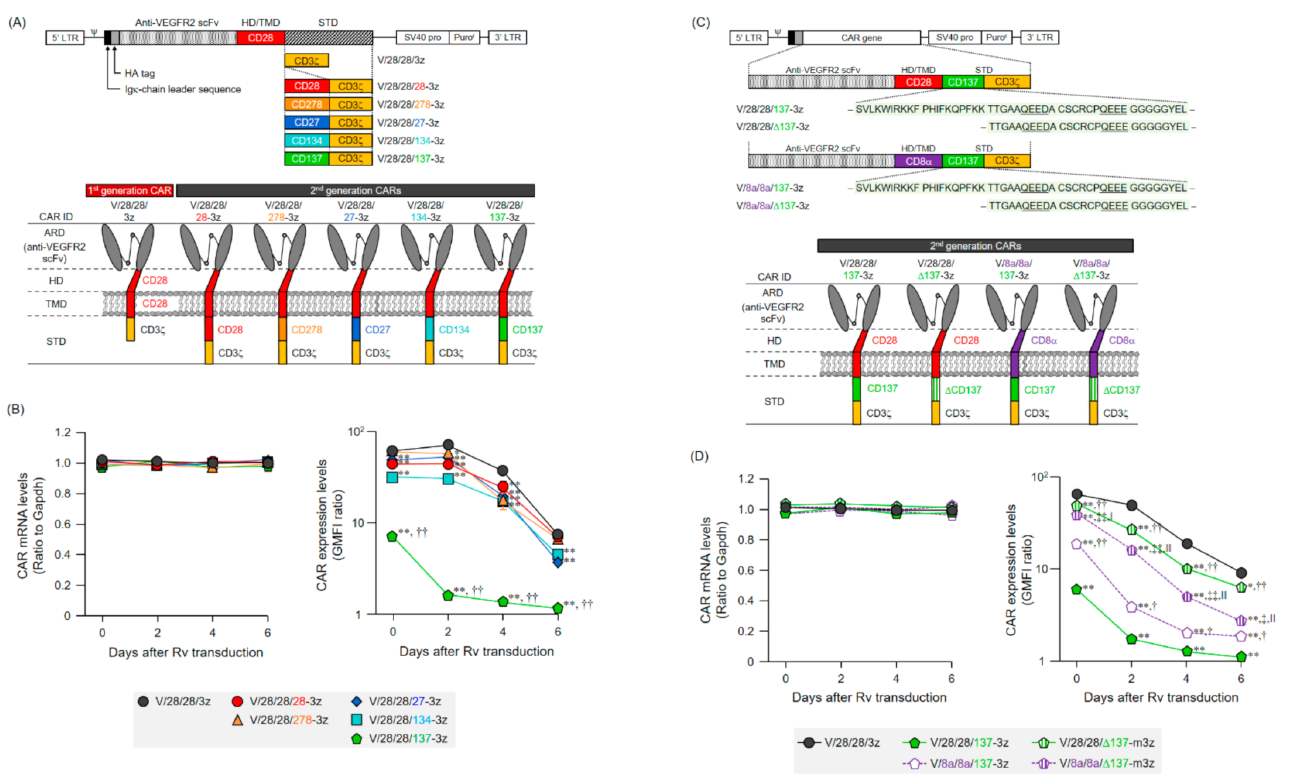
Figure 1. Expression of anti-mouse VEGFR2 second-generation CARs with different STDs. ( A ) Upper panel illustrates the Rv constructs containing the anti-mouse VEGFR2 first-generation CAR gene and second-generation CAR genes with a CD3 ζ -STD (1st STD) and 2nd STD derived from different co-stimulatory molecules for mouse T cells. Lower panel represents STD-modified CAR proteins. ( B ) The left panel shows the results of reverse transcription and quantitative PCR (RT-qPCR) analysis of CAR mRNA. CAR mRNA expression level is represented relative to that of Gapdh mRNA. The data are shown as the mean ± SD of triplicates, and are representative of two independent experiments. Statistical analysis was performed using the Dunnett’s test for multiple comparisons with V/28/28/3z and showed no significant differences. The right panel shows the results of flow cytometric analysis of CAR expression on CD8 + T cells using anti-HA-tag mAb or isotype control antibodies. Expression level of each CAR was calculated from the ratio of GMFI when stained with the anti-HA-tag mAb to GMFI when stained with the isotype control antibody. The data shows the mean ± SD of three individual experiments. Statistical analysis was performed using the Dunnett’s test for multiple comparisons with V/28/28/3z: ** p < 0.01; and using the Tukey’s test with V/28/28/137-3z versus V/28/28/28-3z, V/28/28/278-3z, V/28/28/27-3z, and V/28/28/134-3z: †† p < 0.01. ( C ) Upper panel illustrates the Rv constructs containing the anti-mouse VEGFR2 second-generation CAR genes with CD28- or CD8 α -derived HD/TMD and CD137-derived STD or truncated CD137 ( ∆ CD137)-derived STD for mouse T cells. Lower panel shows representation of the corresponding CAR proteins. ( D ) The left panel shows the results of RT-qPCR analysis of CAR mRNA. CAR mRNA expression level is represented relative to that of Gapdh mRNA. The data are shown as the mean ± SD of triplicates, and are representative of two independent experiments. Statistical analysis was performed using the Tukey’s test for multiple comparisons and showed no significant differences. Right panel, CAR expression on T cells was analyzed by flow cytometry. The expression level of each CAR was calculated from the ratio of GMFI when stained with the anti-HA-tag mAb to GMFI when stained with the isotype control antibody. The data shows the mean ± SD from three individual experiments. Statistical analysis was performed using the Dunnett’s test for multiple comparisons with V/28/28/3z: * p < 0.05 and ** p < 0.01; and using the Tukey’s test with V/8a/8a/137-3z and V/28/28/ ∆ 137-3z versus V/28/28/137-3z: † p < 0.05 and †† p < 0.01; V/8a/8a/ ∆ 137-3z versus V/28/28/ ∆ 137-3z: ‡ p < 0.05 and ‡‡ p < 0.01; V/8a/8a/ ∆ 137-3z versus V/8a/8a/137-3z: | p < 0.05 and (cid:107) p <